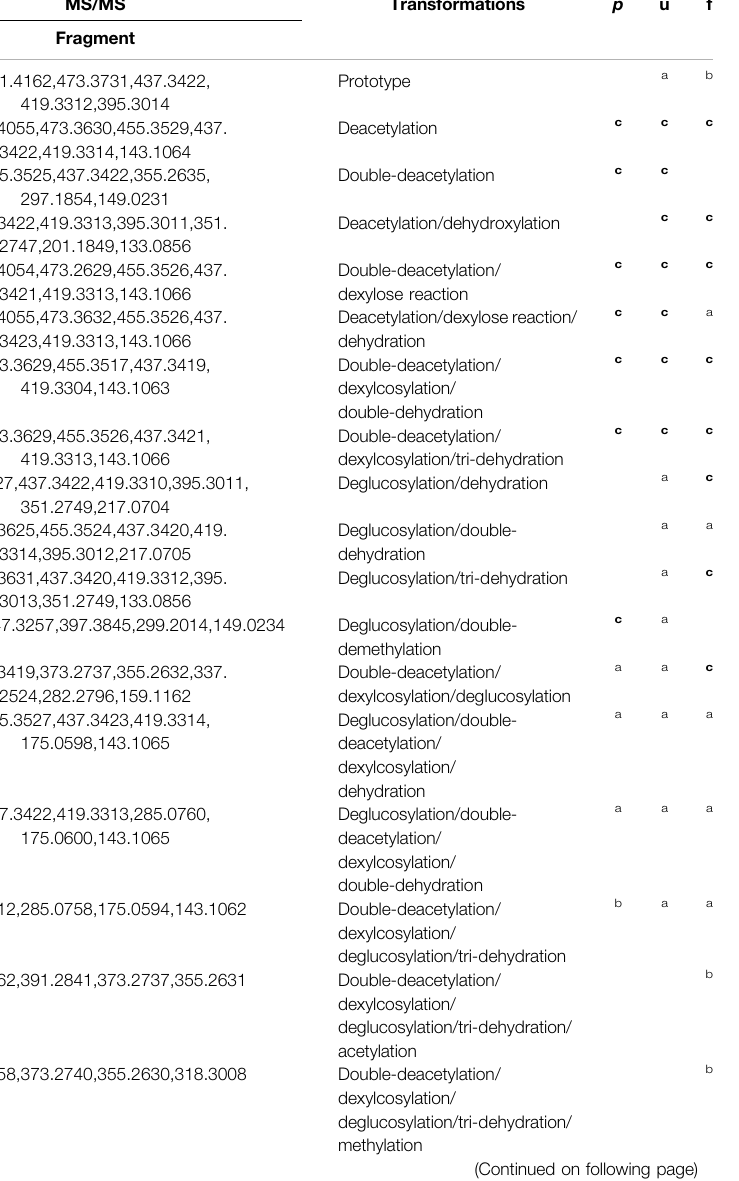
TABLE 1 | Characterization of in vivo metabolites of eggplant green calyx compounds 1 – 6 by UPLC/ESI/Q-TOF-MS.